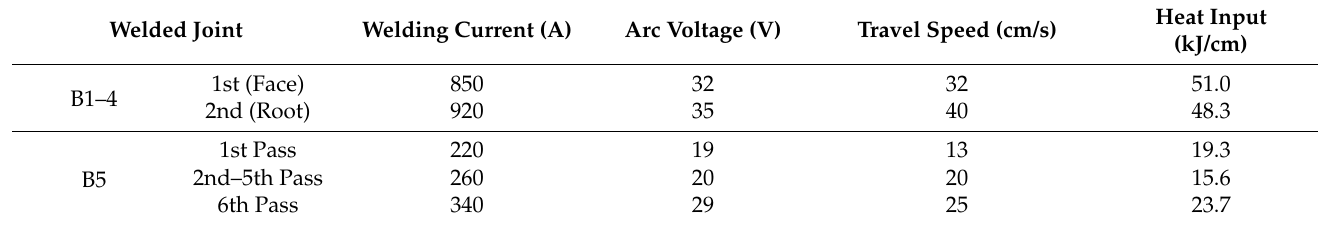
Table 4. Welding conditions.